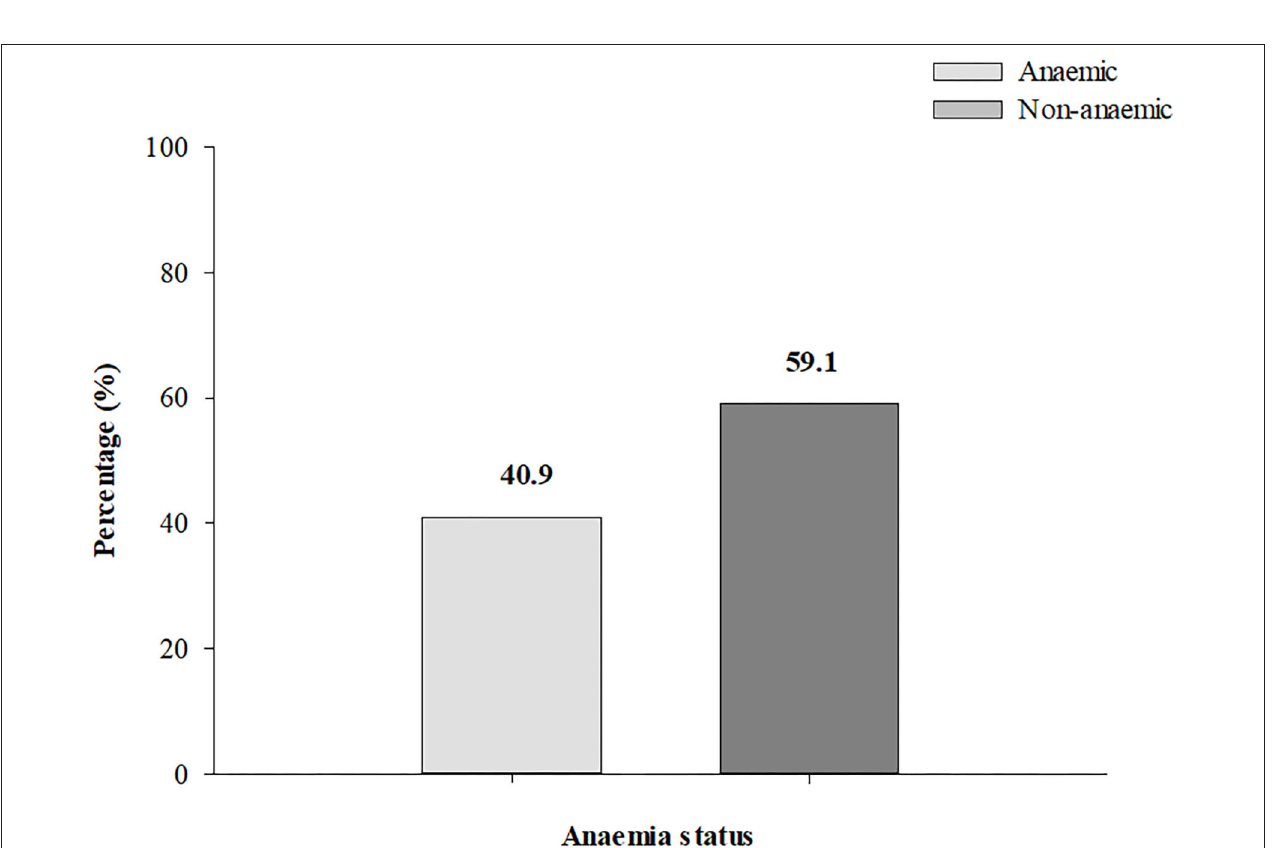
FIGURE 1 | Prevalence of anemia among pregnant women.